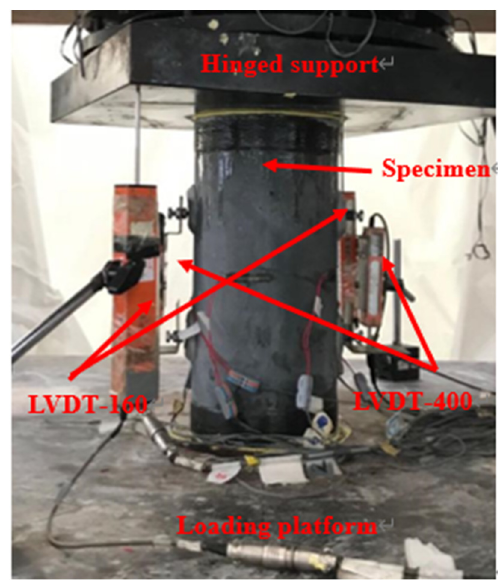
Figure 8. Test set-up.